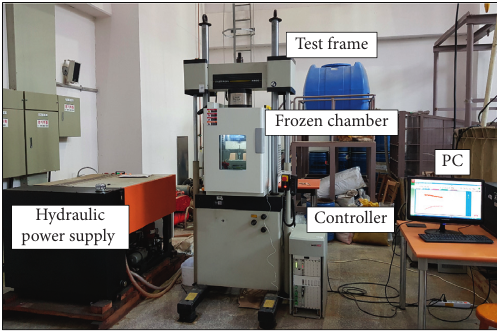
Figure 8: Picture of the testing system.